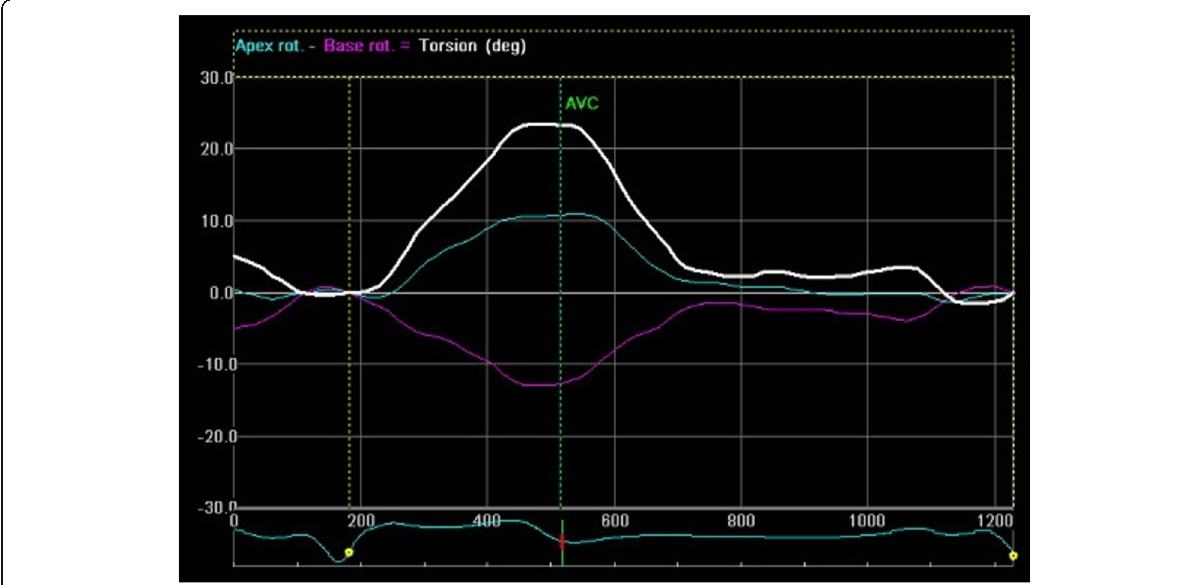
Fig. 2 Speckle tracking echocardiography (Echo Pac software) in patients with HCM showing net basal rotation (purple color) in counter- clockwise direction and net apical rotation (green color) in clockwise direction. Net torsion is displayed in white